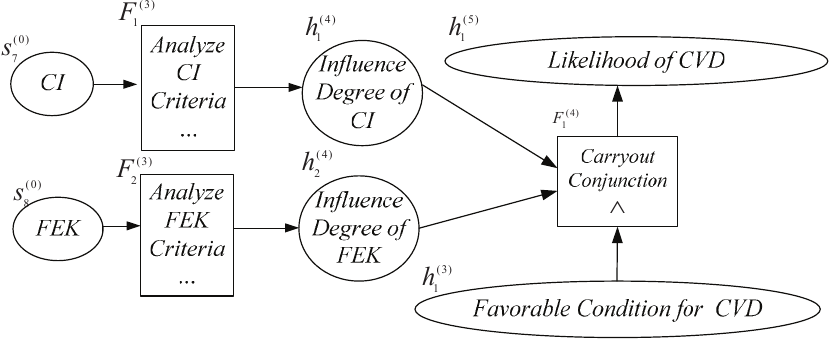
Figure 6. GBINM guides constructing branches 4 and 5 and linking them to